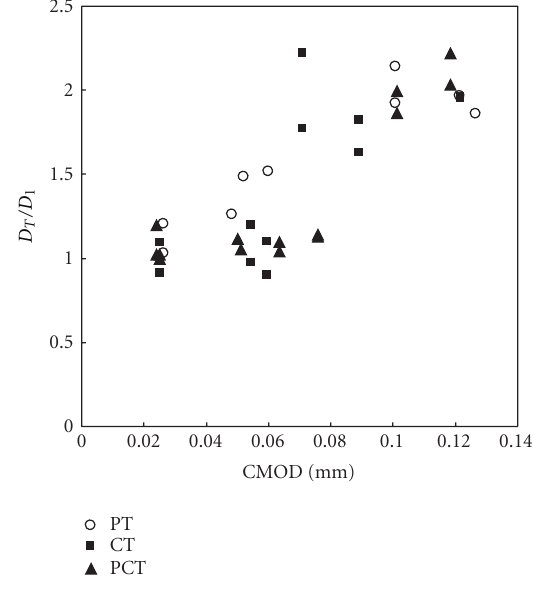
Figure 14: Relative chloride di ff usion coe ffi cient ( D T /D 1 ) for surface treated